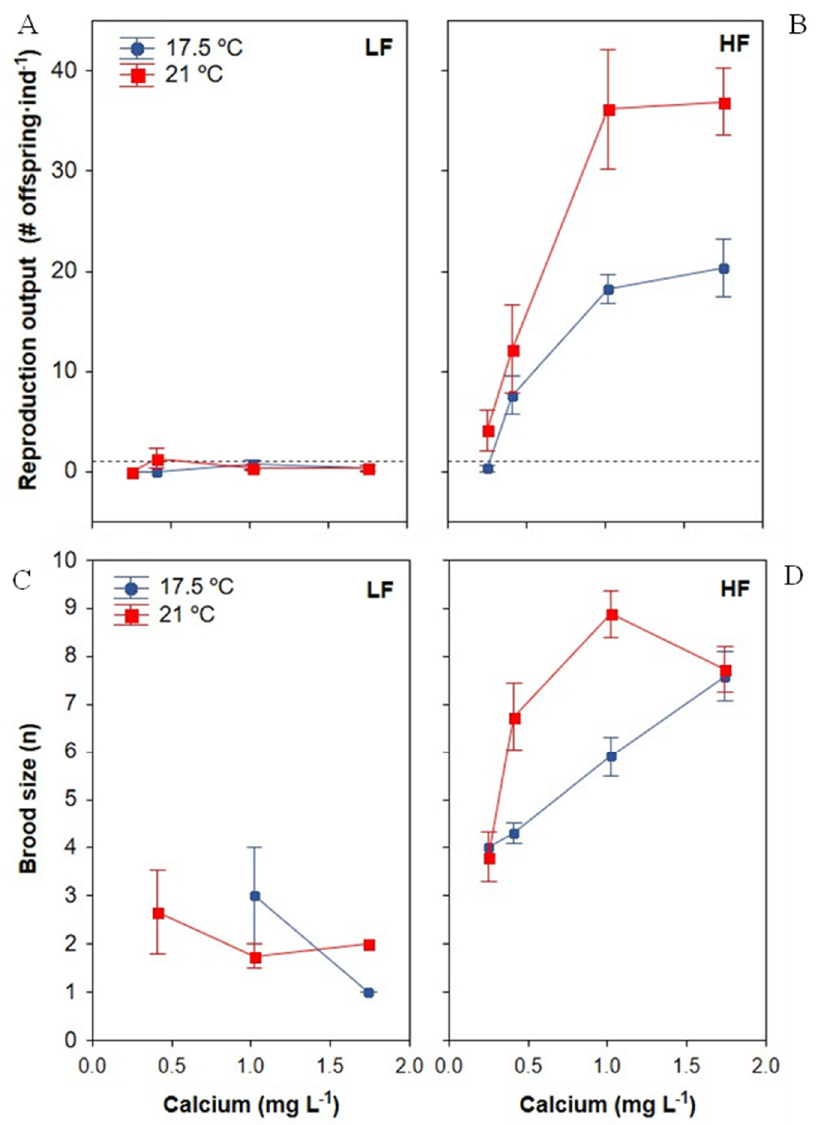
Figure 5. Effects of calcium concentration on reproductive traits of D. pulex at two temperatures and low (LF) or high (HF) food level. Data represent mean ± SE. ( A , B ): Reproduction output. The dotted line shows level reproduction output = 1 ( i.e., each individual could give rise to one offspring but not itself survive, and the population size would stay approximately constant); ( C , D ): Brood size. Error whiskers are not given for the 21 °C LF 1.74 mg Ca L − 1 and 17.5 °C HF 0.25 mg Ca L − 1 treatments because only one experimental female produced offspring.